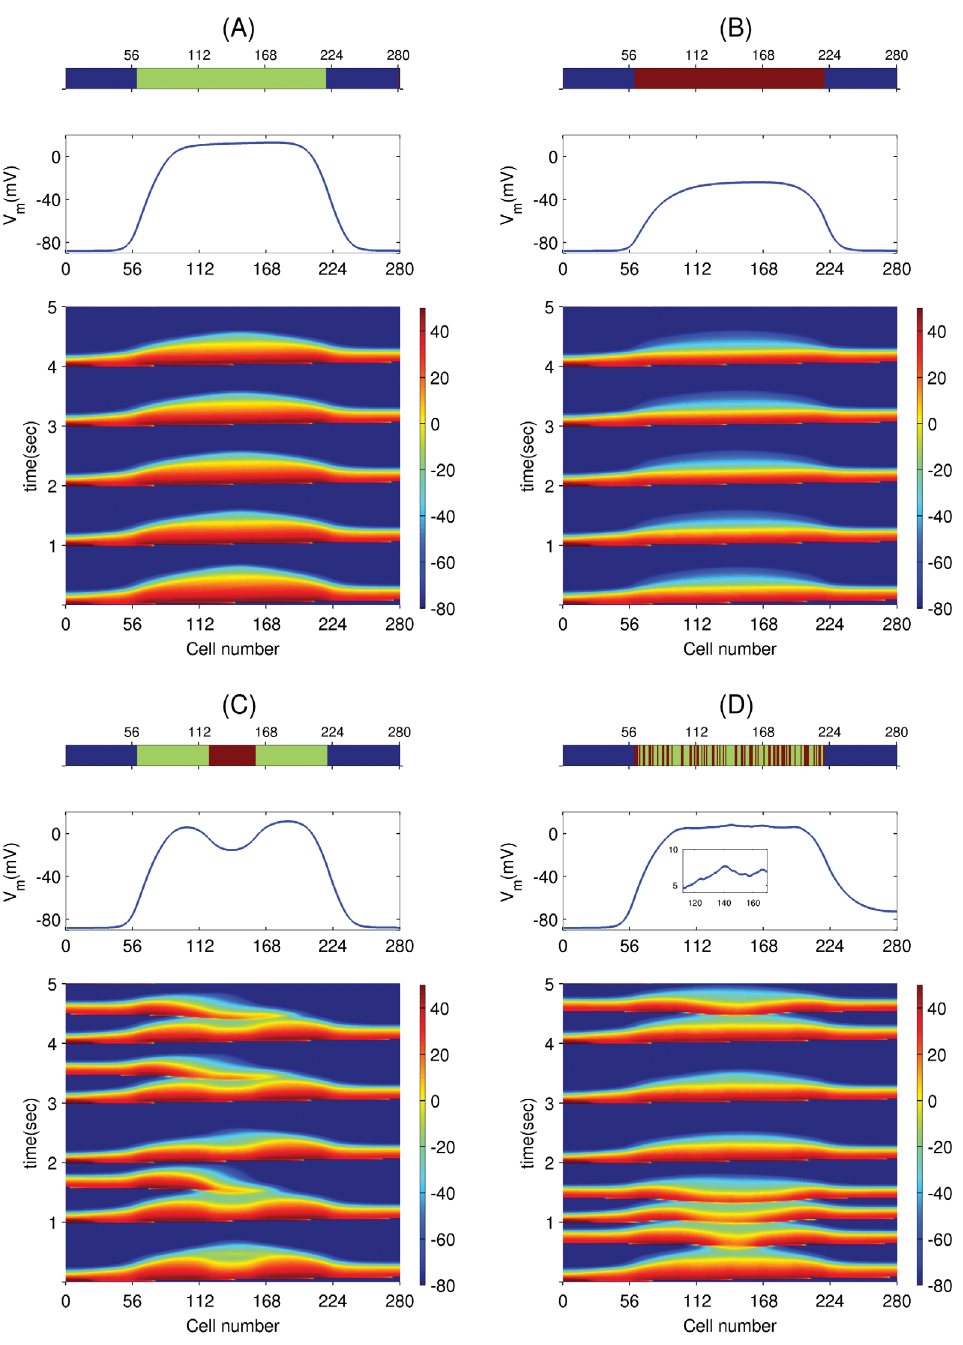
Fig 12. PVC triggering depends on the EAD myocyte-fibroblast pattern. The top panels of (A), (B), (C), and (D) show the distribution of fibroblasts in a one dimensional cable of 280 cells, where blue, green, and brown indicate normal myocyte, EAD myocyte, and EAD myocyte-fibroblast composites, respectively. The panels in the second row show V m along the cables 20 ms after the passage of a wave. The panels in the third row show the space-time plots of V m in the cables, when the cable is paced with PCL = 1000 ms from the left-side end of the cables. The patterns (C) and (D) trigger PVCs, whereas the patterns (A) and (B) do not.